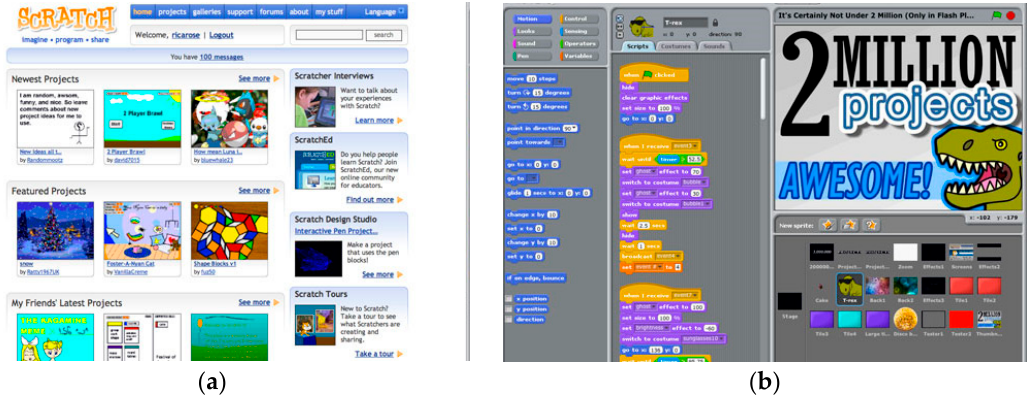
Figure 1. ( a ) The Scratch Online Community; ( b ) Scratch programming environment.